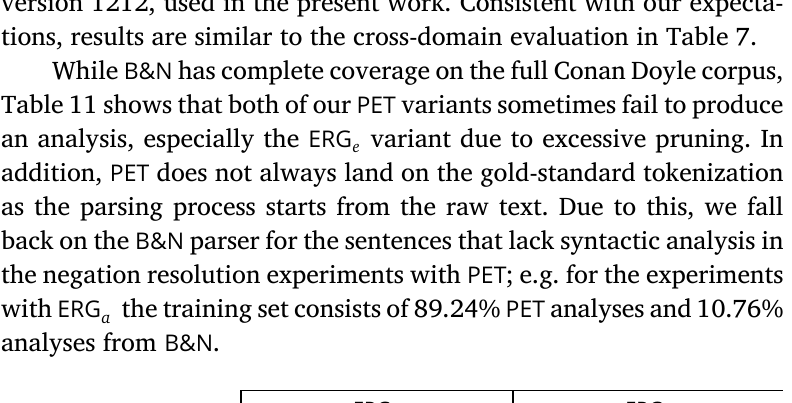
PET coverage on Conan Doyle and alignment with ‘gold’